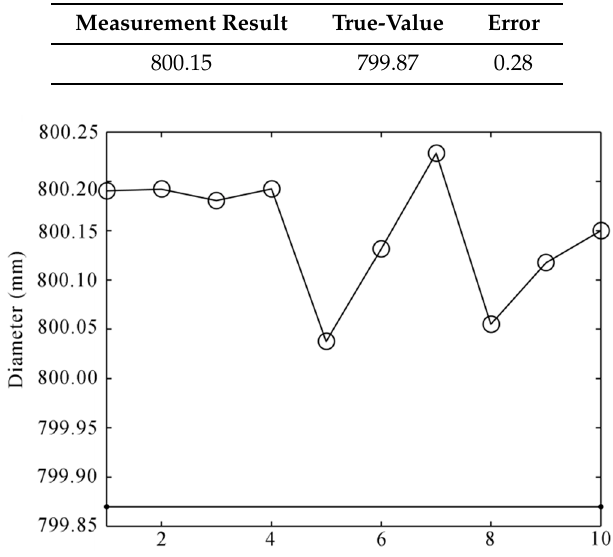
Table 2. Diameter result of the static experiment (in millimeters).